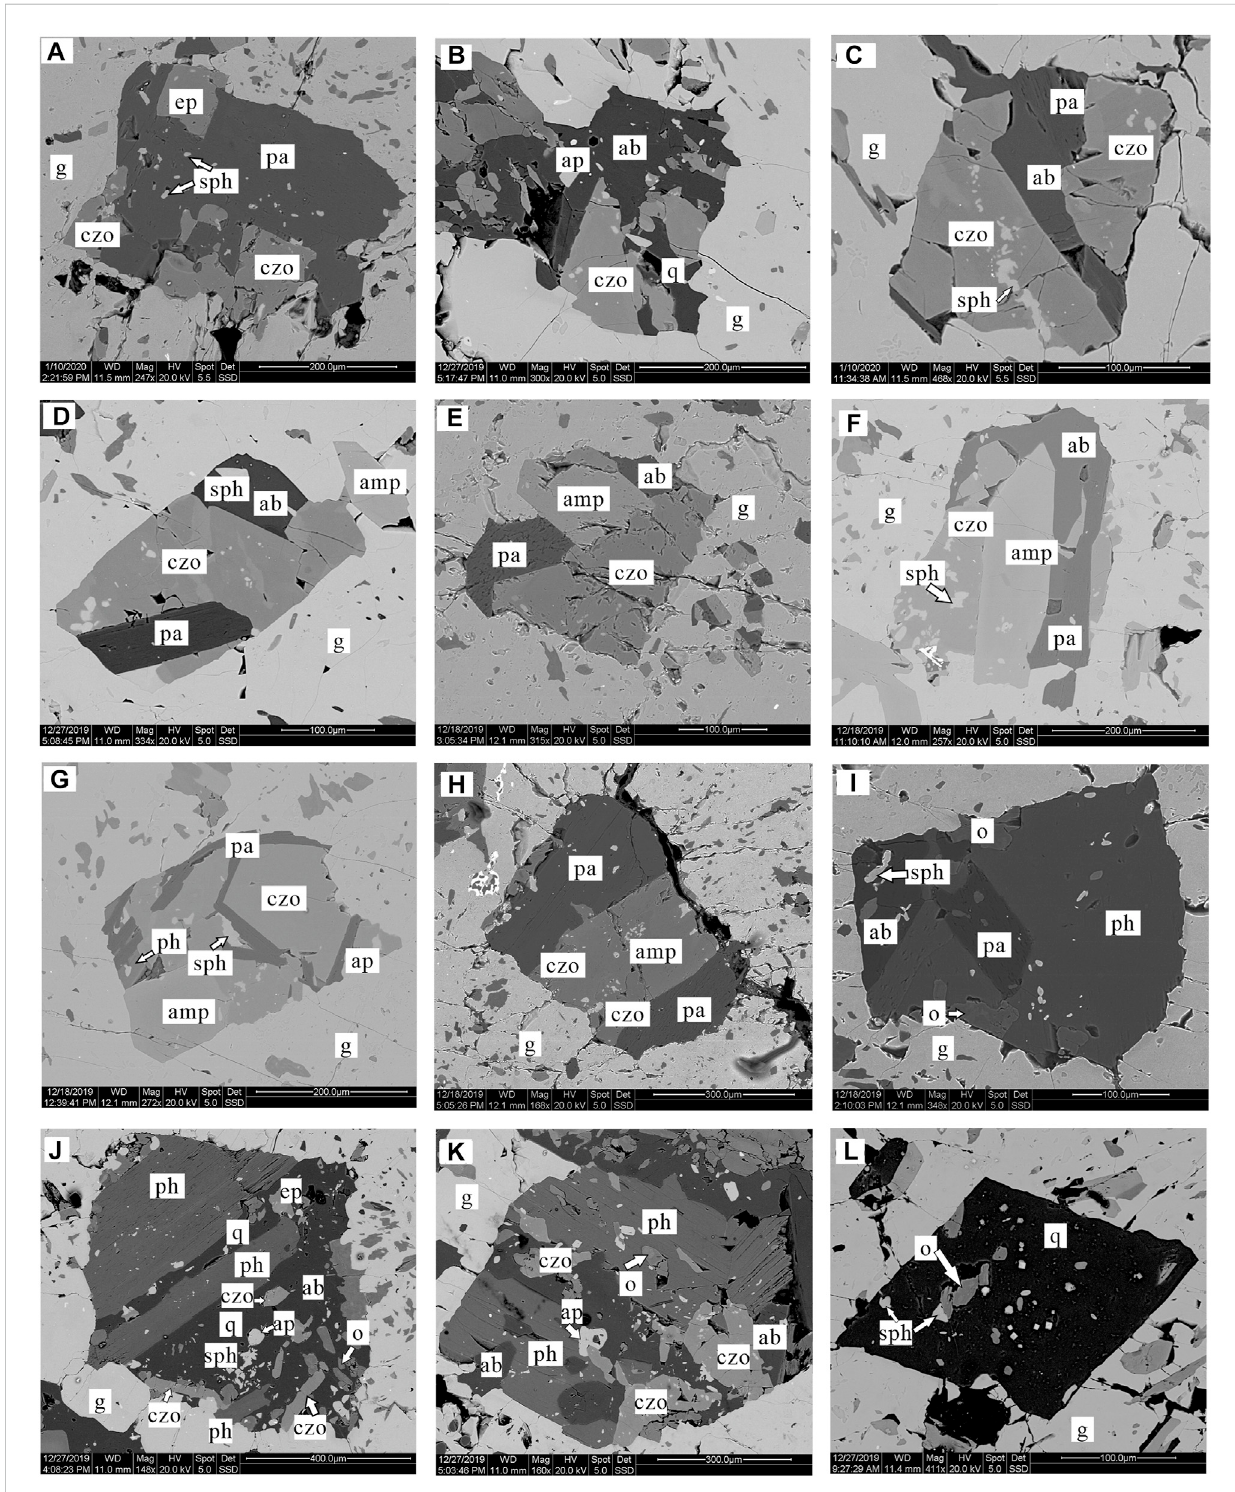
FIGURE 5 Backscattered electron images showing various composite inclusions in garnet de fi ne rectangular or rhombic shapes, maybe pseudomorphs after lawsonite. (A – D) composite inclusions dominated by ep/czo + pa/ab; (E – H) amp-bearing composite inclusions dominated by czo + pa/ab + amp; (I – K) ph-bearing composite inclusions dominated by ep/czo + pa/ab + ph; (L) quartz with relics of omphacite, epidote and sphene showing rhombic